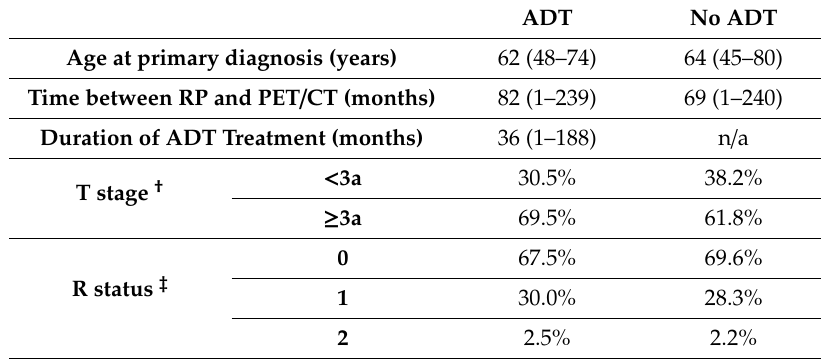
Table 2. Demographic and clinical characteristics of case and control